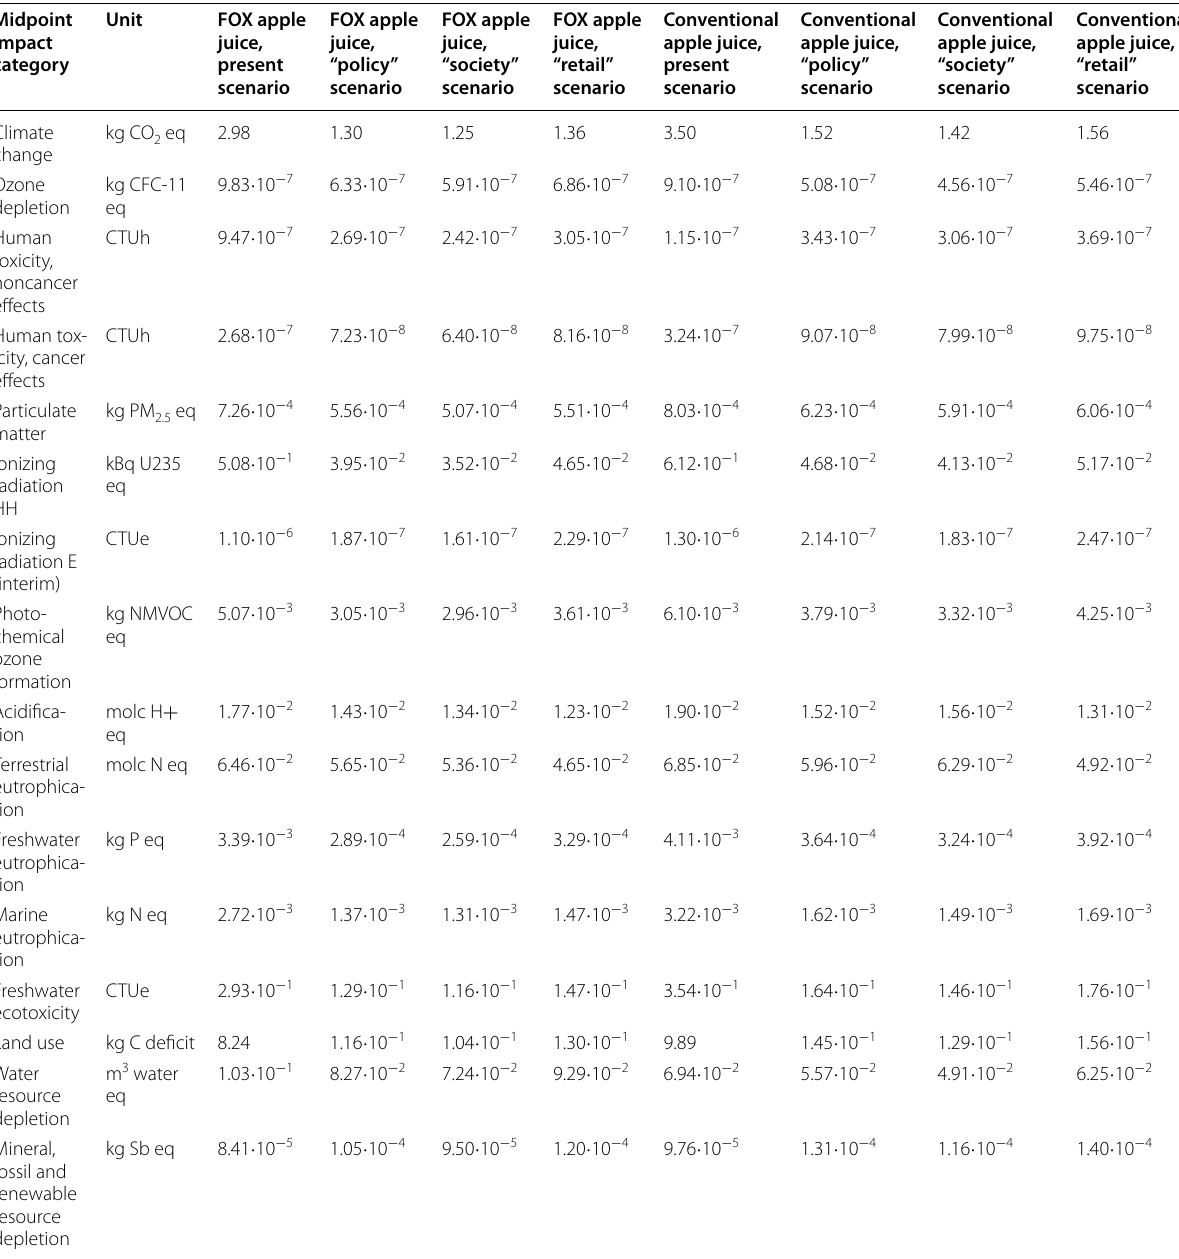
Table 2 Environmental impacts of FOX a and conventional apple juice calculated with ILCD 2011 Midpoint